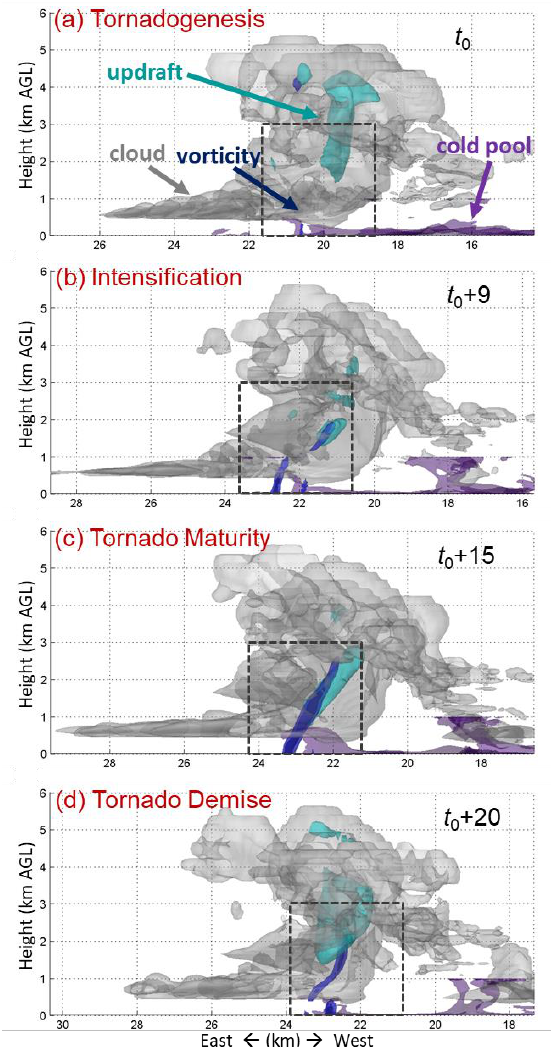
Figure 4. Three-dimensional perspective of the simulated tornado and cumulonimbus cloud at the ( a ) tornadogenesis, ( b ) intensification, ( c ) maturity and ( d ) demise stages. The isosurfaces in grey, cyan, blue and purple denote the cloud water vapor mixing ratio (0.1 g kg − 1 ), vertical velocity (15 m s − 1 ), vertical vorticity (0.1 s − 1 ) and potential temperature perturbation ( − 1 K, showing the temperature properties of the cold pool), respectively. The perspective is from the north.